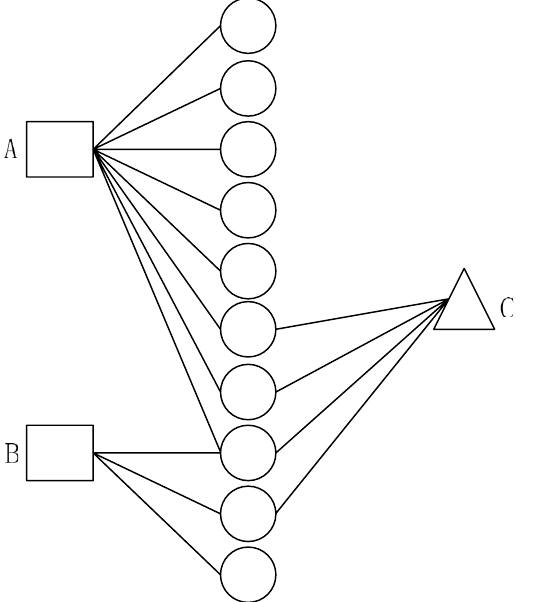
Figure 1. Example of understanding HeteSim measure. Circle, squares and triangle denote three different kinds of objects in the heterogeneous